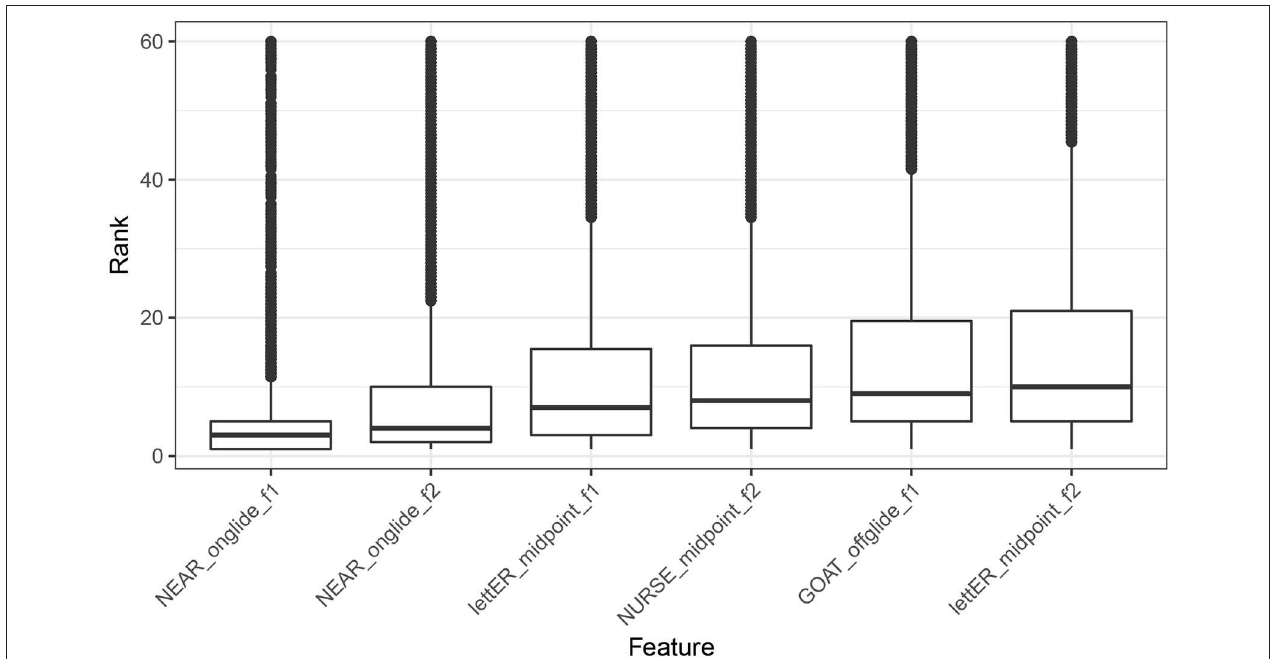
FIGURE 3 | Distribution of feature ranking across all the models for